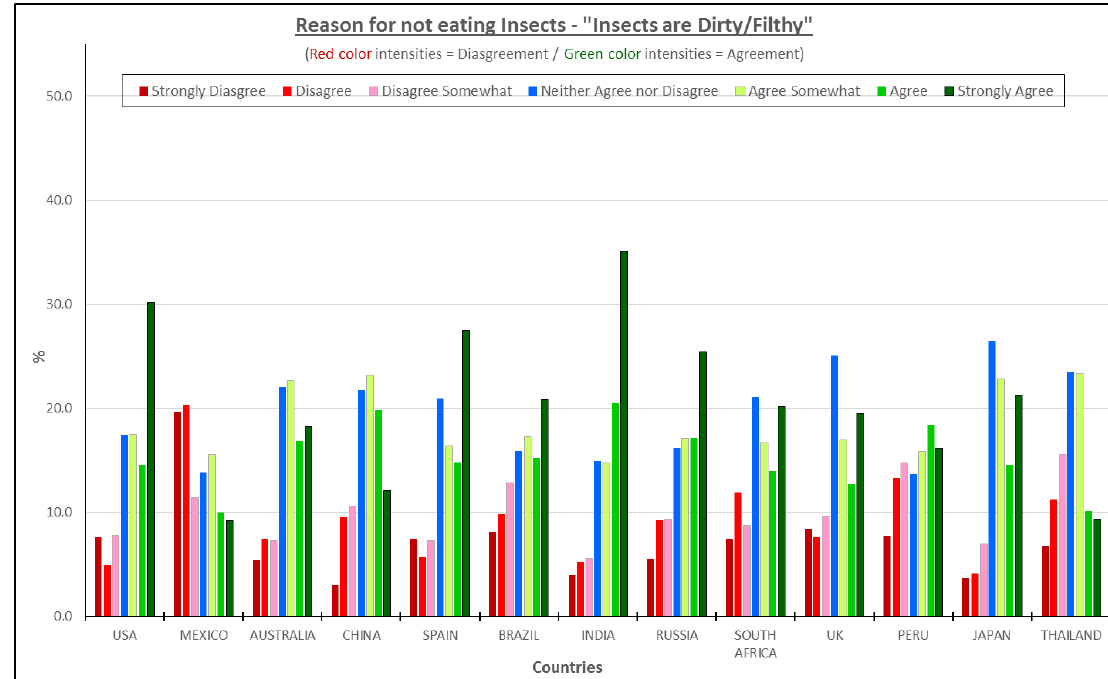
Figure 6. The reasons for not eating insect products—“Insects are not safe to eat”.